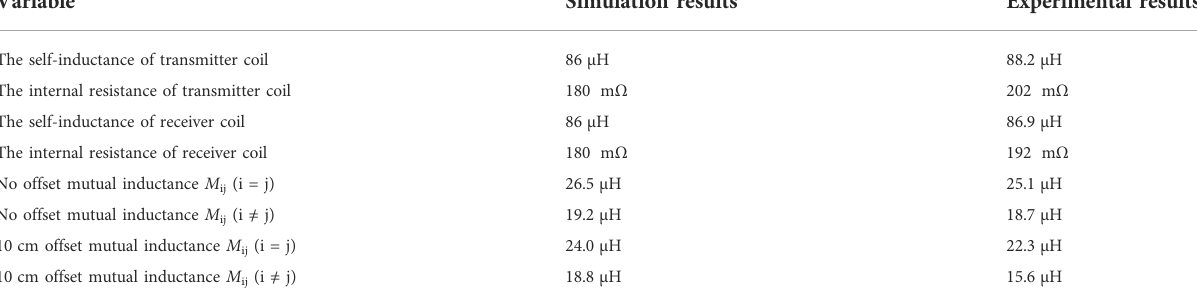
TABLE 2 The comparison between the experimental results and the simulation results.